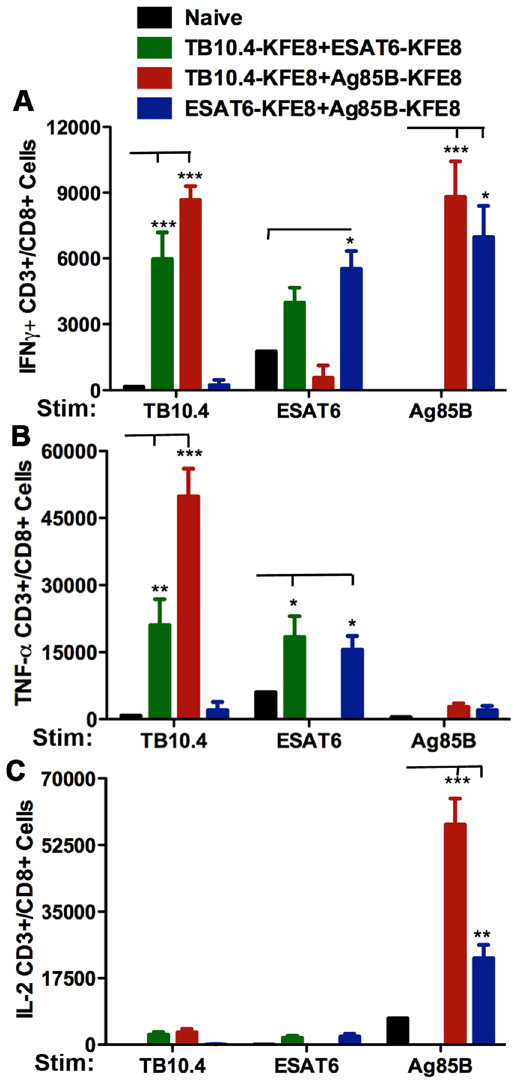
Figure 3. Co-assembled nanofiber vaccines bearing Mtb -specific CD8 + and CD4 + T cell epitopes stimulate robust recall responses. In mice vaccinated with co-assembled nanofibers of TB10.4-Ag85B (CD8-CD4) or ESAT6-Ag85B (CD8-CD4), stimulation with TB10.4, ESAT6, or Ag85B (lymphocytes isolated from popliteal lymph node 90 days post immunization) leads to increased numbers of CD8 + T cells producing IFN- γ , compared to mice vaccinated with TB10.4-ESAT6 (CD8-CD8) nanofibers ( A ). No differences in numbers of IL-2 producing CD8 + T cells were observed in mice vaccinated with TB10.4-Ag85B or ESAT6-Ag85B nanofibers when stimulated with TB10.4 or ESAT6. A significant increase in numbers of IL-2 + and IFN- γ+ CD8 + T cells was observed following stimulation with Ag85B, suggesting activation of antigen-specific helper function by Ag85B-specific CD4 + T cells. The increase in IL-2 + CD8 + T cells was also significantly higher when TB10.4 was co-delivered with Ag85B compared to ESAT6 ( C ). N = 5 mice per group and *** p < 0.001, ** p < 0.01 and * p < 0.05 by two way ANOVA using Bonferroni post hoc test. Calculated p-values are compared to naïve control for each